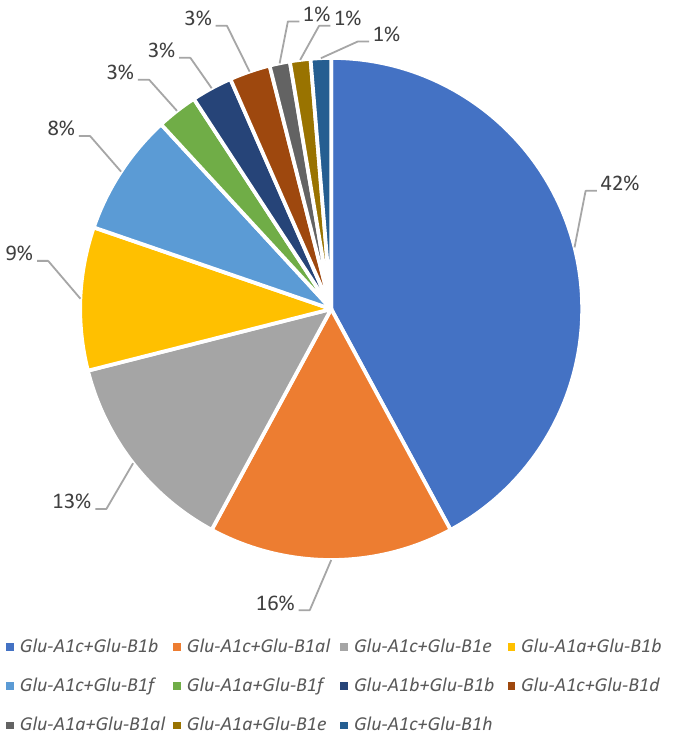
Figure 2. Structure of the winter durum wheat collection by allelic variants of the Glu-A1 and Glu-B1 loci.